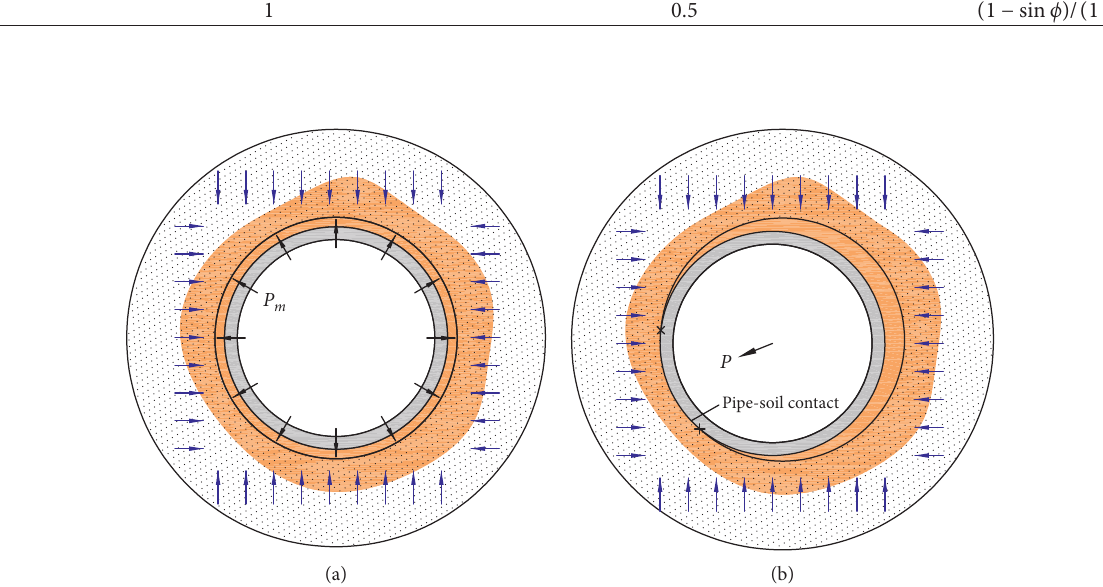
Figure 3: The contact state of pipe soil slurry: (a) the ideal state; (b) the general